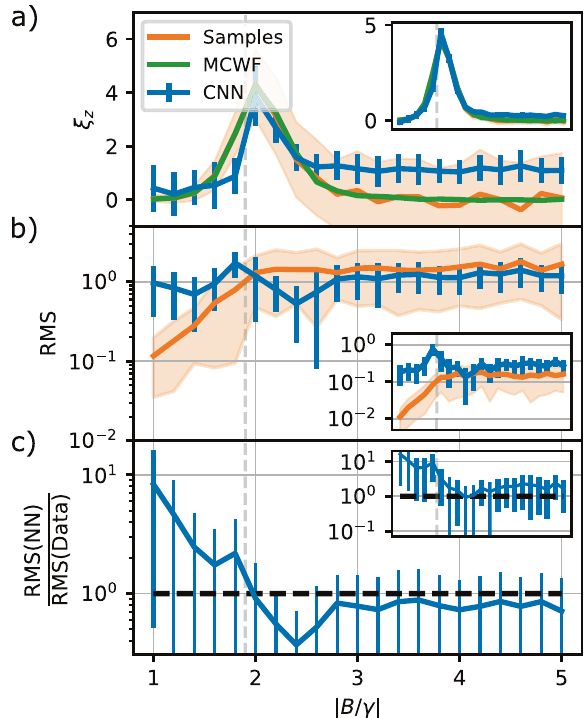
Fig. 6 Tomography of steady states: demonstration of a self- averaging effect. Dissipative phase transition of a 4 x 4 TFIM with spontaneous emission at J = − 1.25 γ with open boundaries. N s = 1 k (insets: 100 k ). Gray vertical line: Point where ↑ and ↓ have been exchanged in POVM. a Observables according to Eq. (12) summed over entire system. b Residual RMS error. c Residual network RMS normalized to dataset RMS. Error bars are standard deviations across multiple independent tomography datasets and neural network training runs with randomly initialized